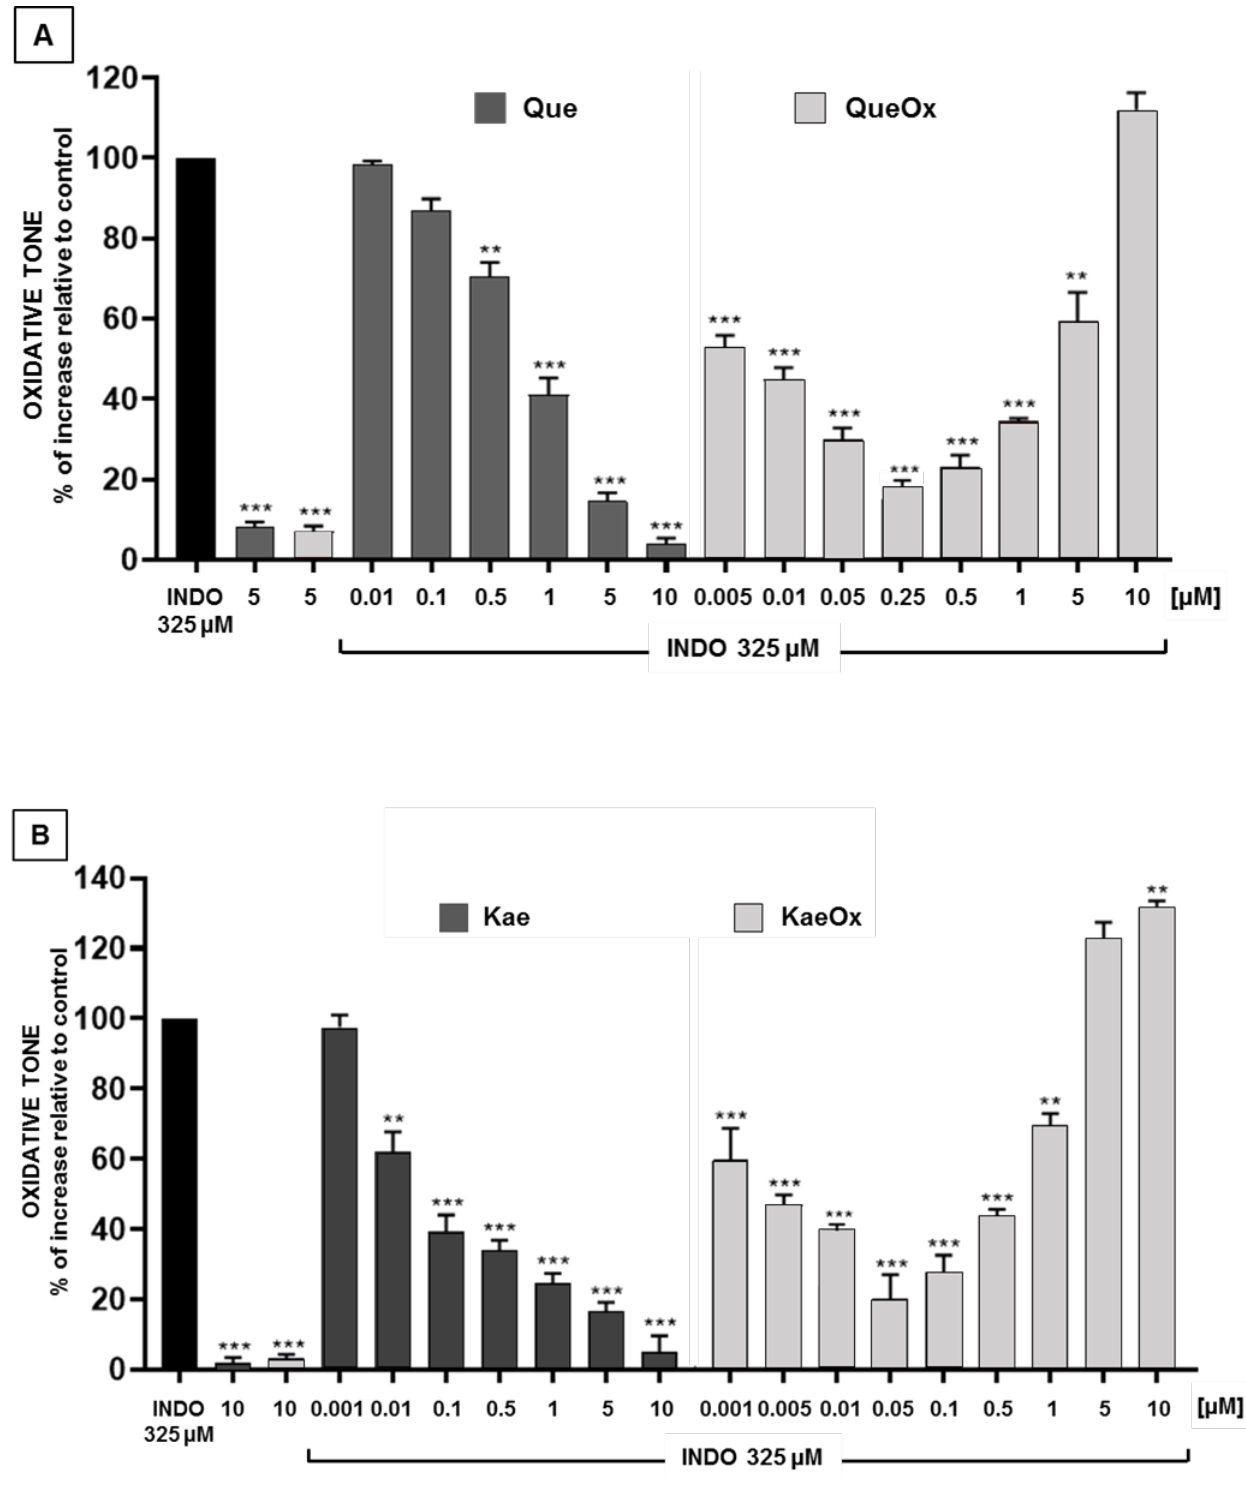
Figure 3. Comparison of the antioxidant effects of quercetin and kaempferol and their respective oxidation mixtures against the increase in intracellular oxidative tone induced by indomethacin. ( A ) Que versus QueOx, and ( B ) Kae versus KaeOx. Significant differences: ** p < 0.01, and *** p < 0.001 relative to indomethacin-treated cells.